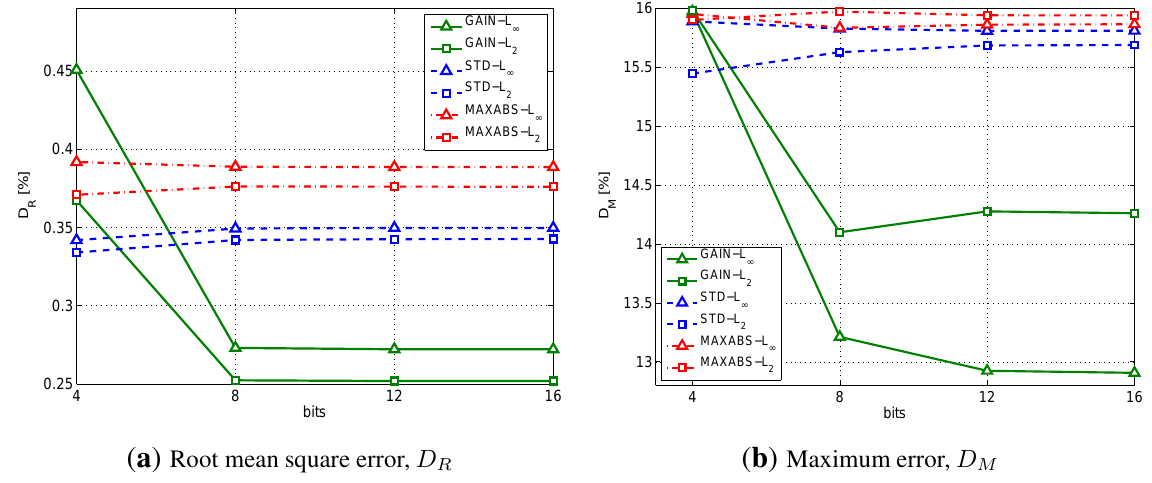
Figure 4. Analysis of the impact of the number of bits used on the compression distortion: ( a ) shows the RMSE of the different dissimilarity metric and gain combinations; while ( b ) provides the maximum error on the same combinations. The Codebook has been computed using K = 16 motifs of N = 20